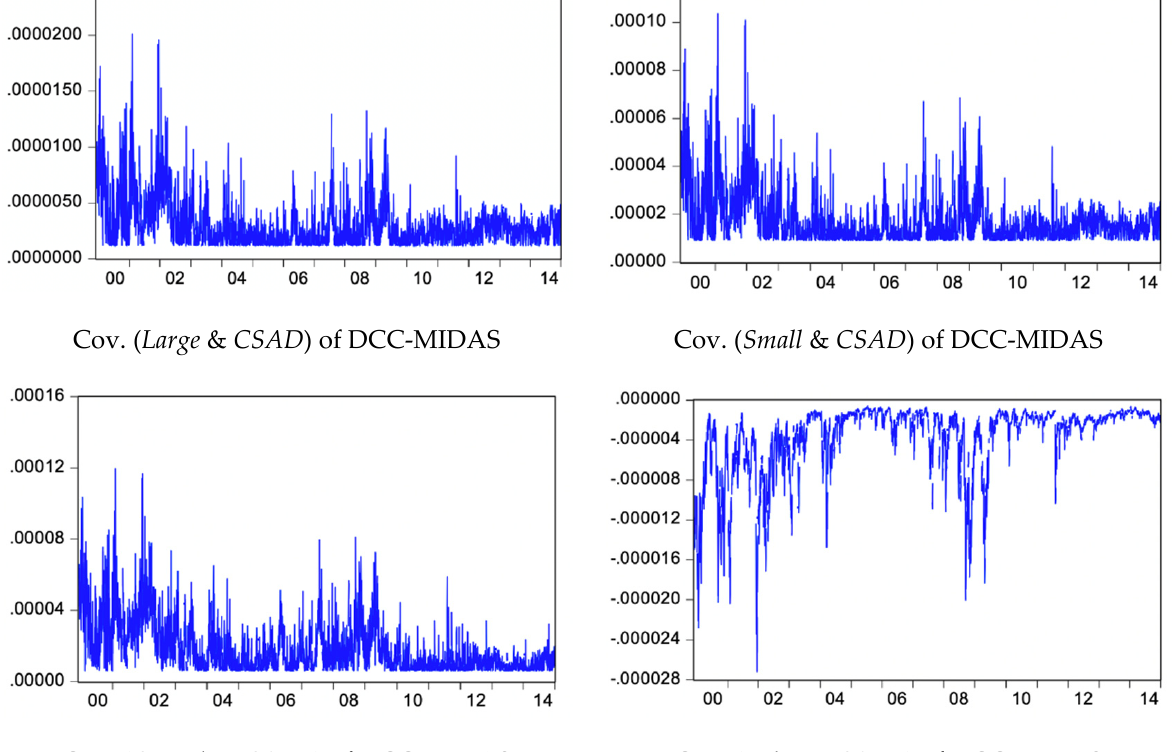
Figure 1. The covariance of the DCC-MIDAS model between the portfolios and CDAD during the full periods (2000–2014).